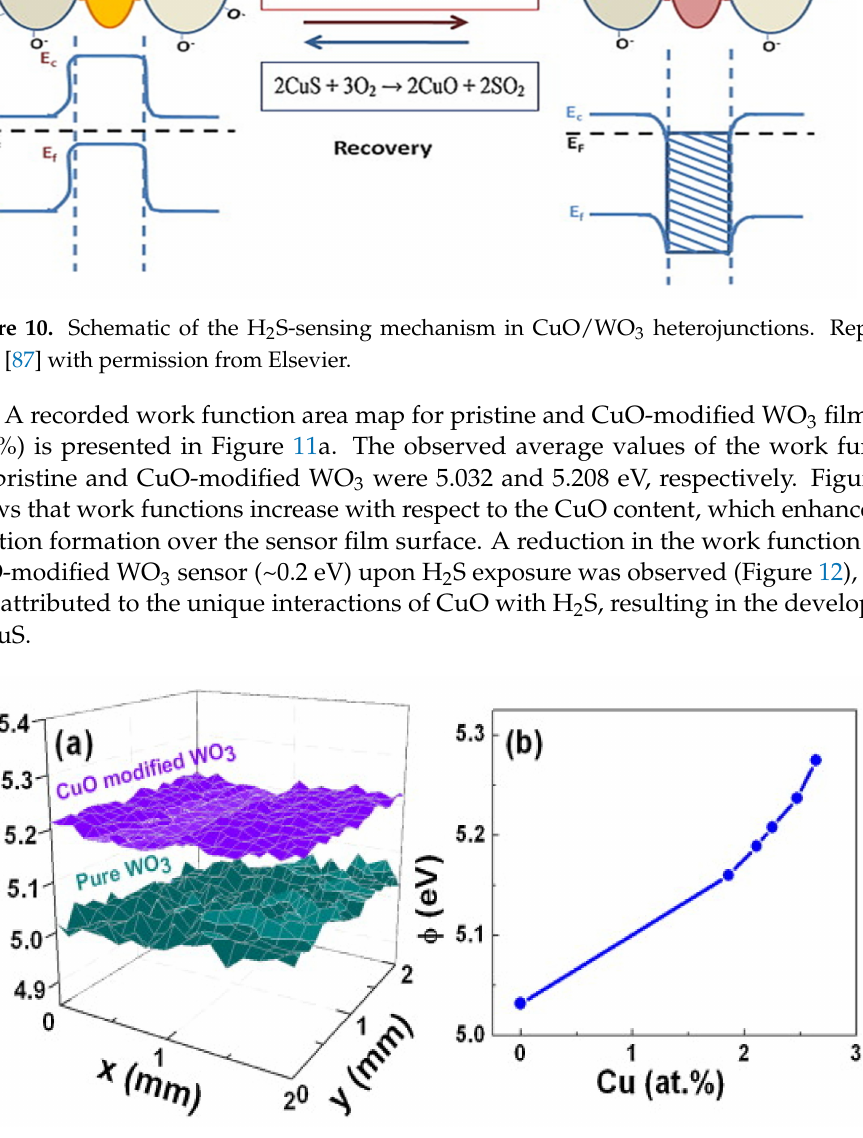
Figure 11. ( a ) Work function area maps of pristine and CuO-modified WO 3 films; ( b ) plot of change in work function vs. Cu (at/%). Reprinted from [87] with permission from